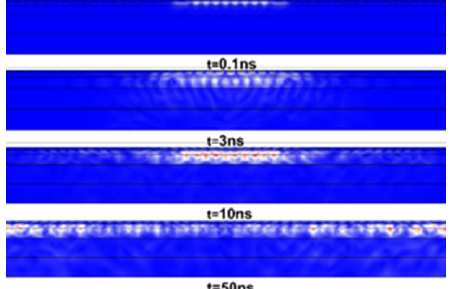
Figure 18. Simulation diagram of surface acoustic wave propagation in the structure.